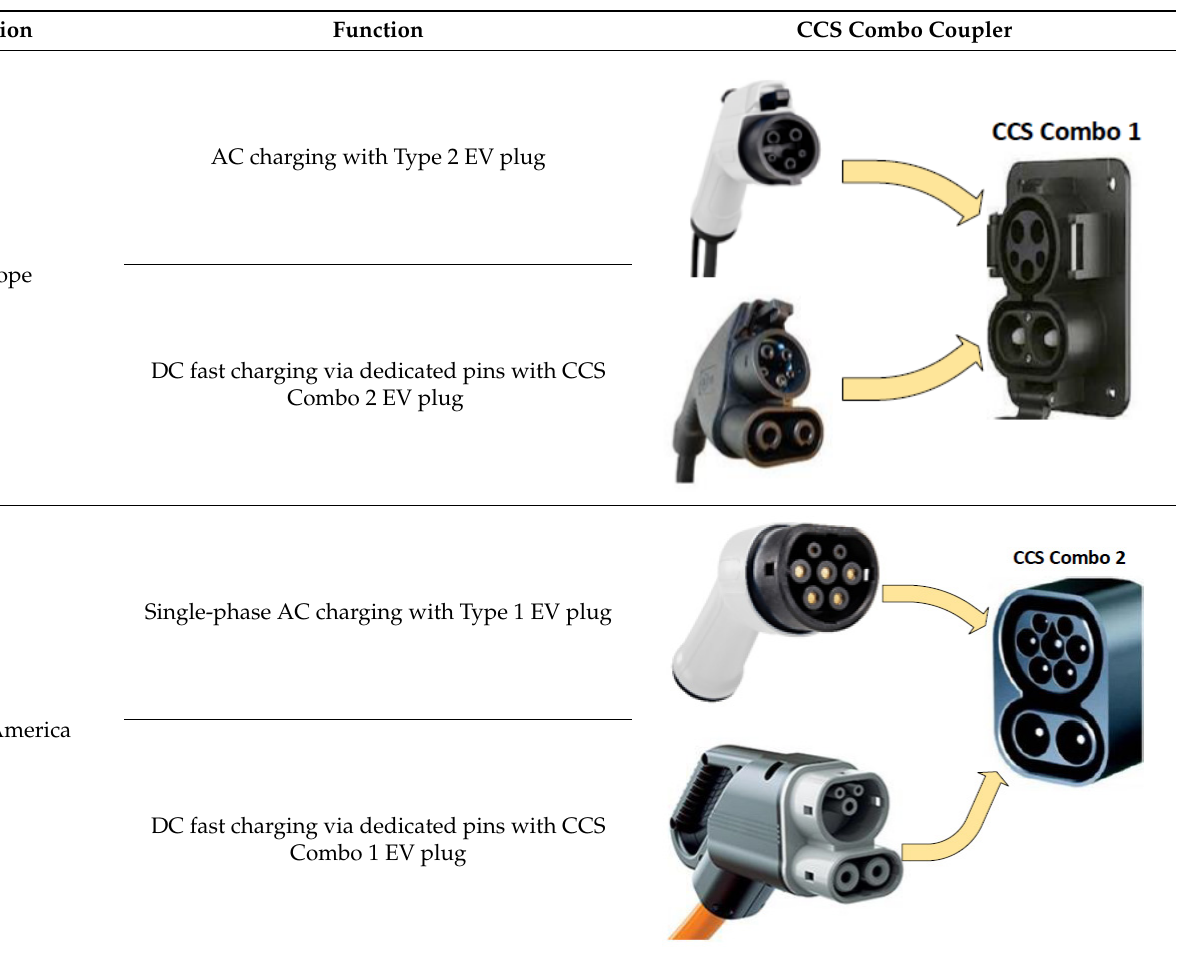
Table 8. CCS Combo Coupler specifications.